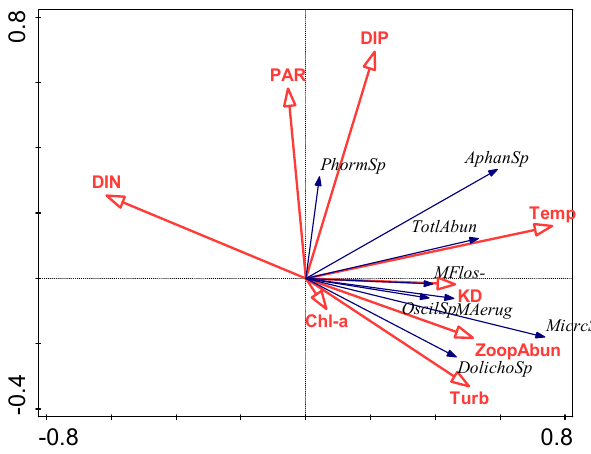
Figure 8. RDA biplot of the environmental variables and potentially toxic species. Total abundance (TotlAbun) and potentially toxic cyanobacteria species ( Microcystis sp. = MicrcSp; M. aeruginosa = MAerug; M. flos-aquae = MFlos-; Dolichospermum sp. = DolichoSp; Oscillatoria sp. = OscilSp; Aphanocapsa sp. = AphanSp; Phormidium sp. = PhormSp) are represented by blue lines, whereas environmental factors are represented by red lines.